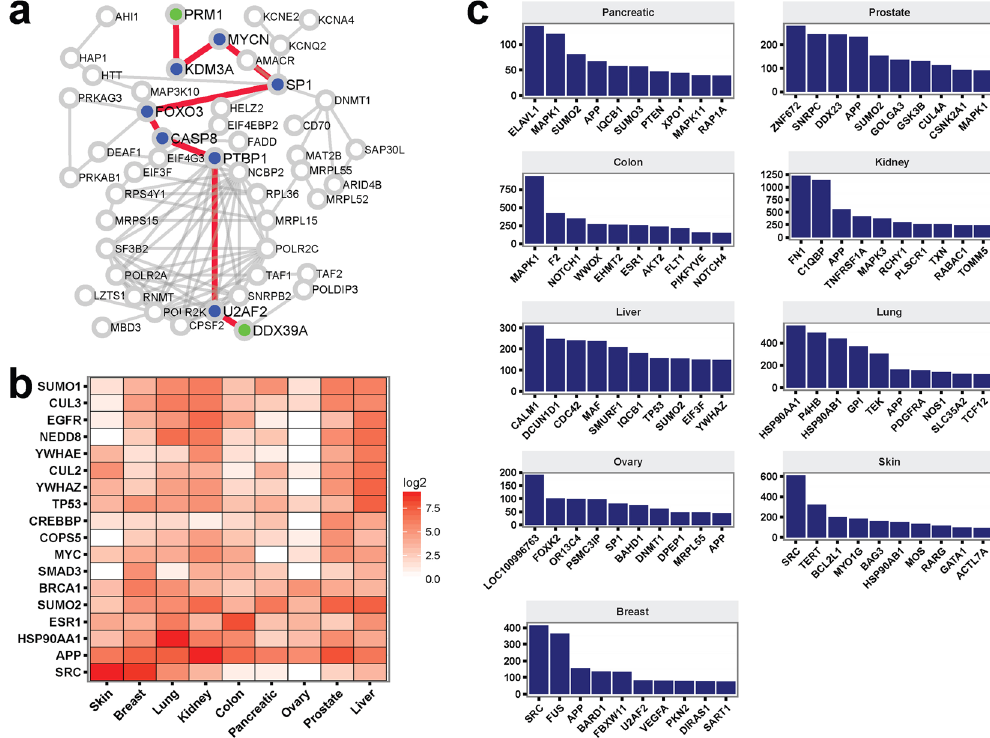
Figure 3. The reconstruction and properties of Protein-Protein Interactions Encapsulated by MINs (PIE- MINs) across different cancer types. ( a ) The construction of PIE-MIN. Here, the gene pair DDX39A-PRM1 (green nodes) from an ovarian cancer inferred network is used as an illustrative example. Of more than ~1,000,000 possible undirected paths connecting a given gene pair, the shortest protein-protein interaction path (red edges) is computed using Dijkstra’s algorithm. The procedure is repeated for all gene pairs in the MIN; proteins found within the shortest path (blue nodes) between all gene pairs comprise the complete PIE-MIN for a given cancer. ( b ) Genes universally observed in all 9 cancer PIE-MINs. Heatmap plot based on the frequency of the shortest paths passing through a given gene for all gene pairs in a MIN at log2 scale. ( c ) Enriched canonical pathways for PIE-MIN using genes of top 500 frequencies. Heatmap plot based on the negative of enrichment p-values at log2 scale. ( d ) PIE-MIN genes of top 10 highest frequencies that appeared in shortest paths for all gene pairs in a MIN for each cancer